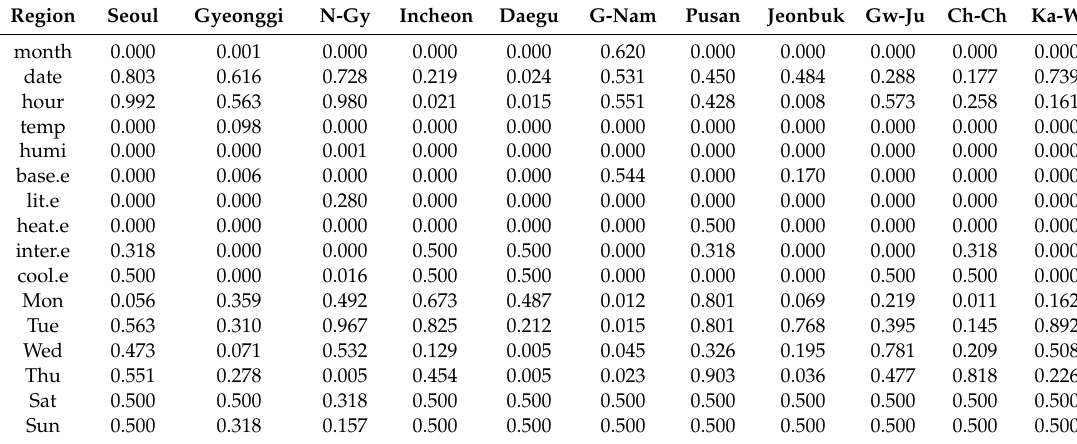
Table 6. Result of the t -test of the 11